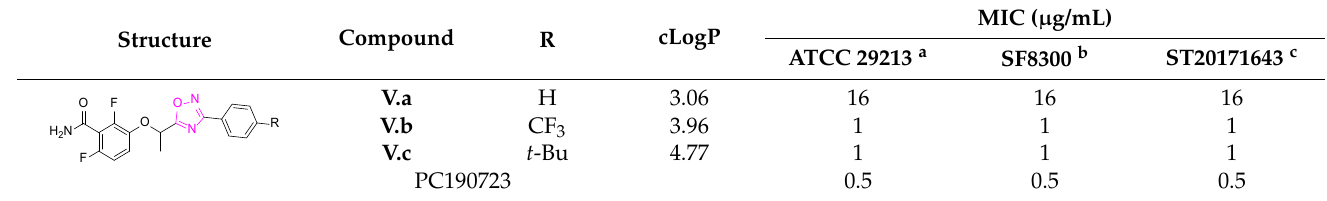
Table 2. Minimum inhibitory concentrations of series V molecules against S. aureus strains.